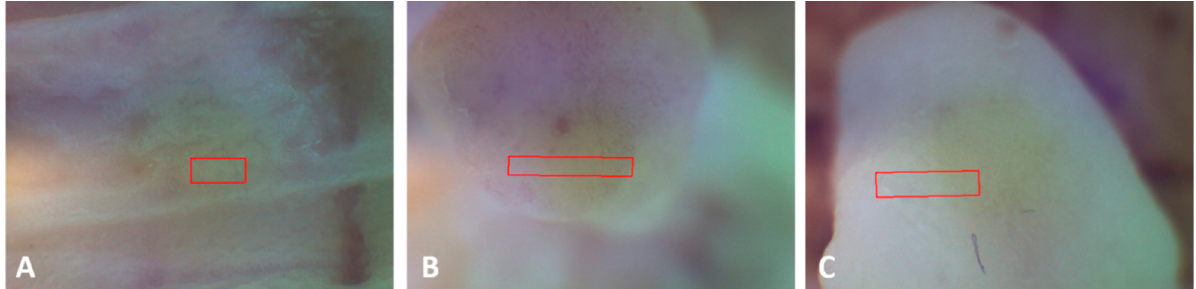
Figure 1. Pre-view of tissue/lesions with C-scan scanning area selected in red. ( A ): healthy sample; ( B ): neoplastic polyp 1; ( C ): neoplastic polyp 2.